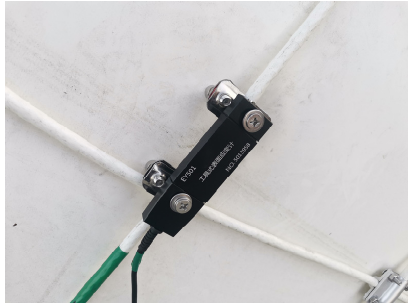
Figure 15. Surface strain gauge.